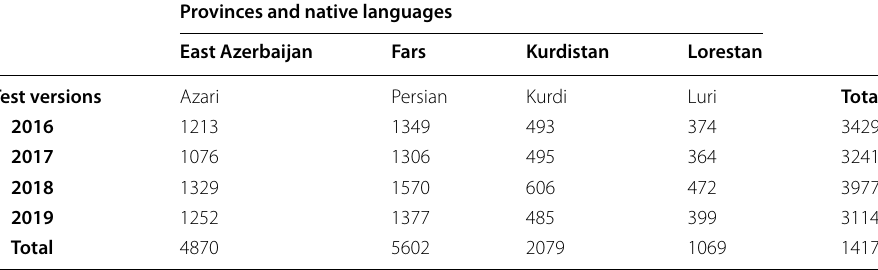
Table 1 Number of participants by province and first